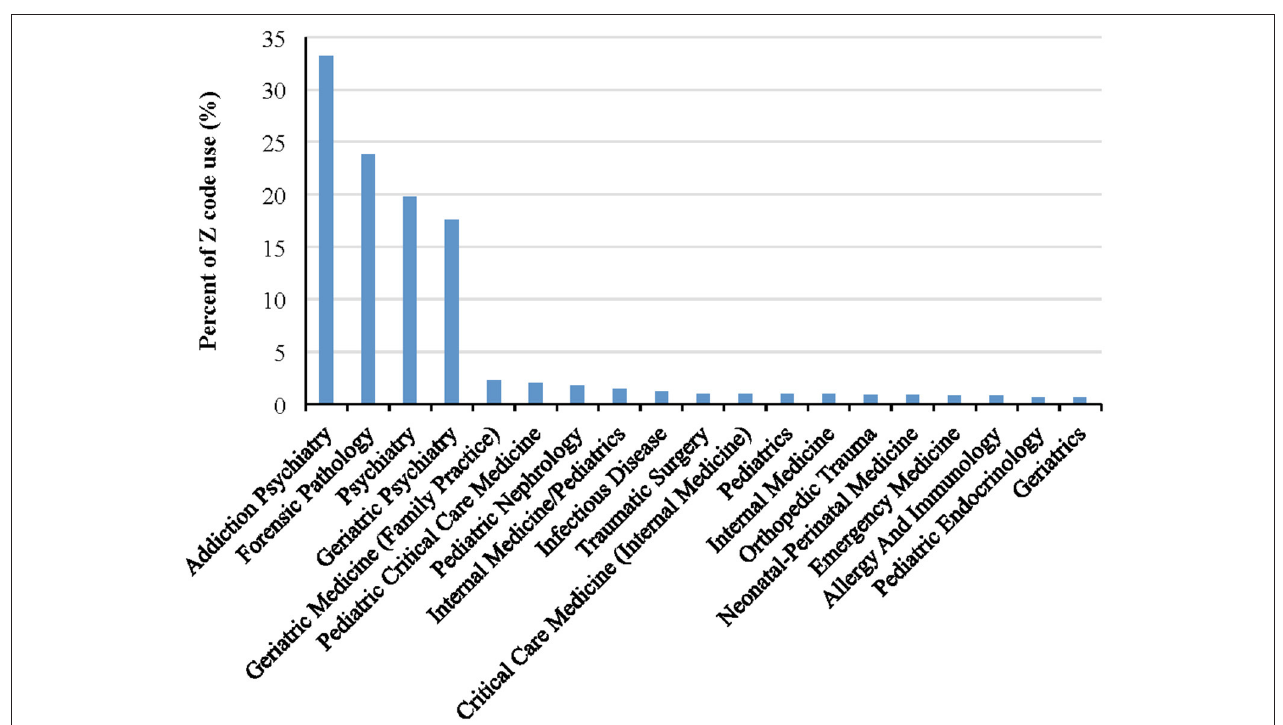
FIGURE 2 | Percentage of clinical visits with Z code use by medical